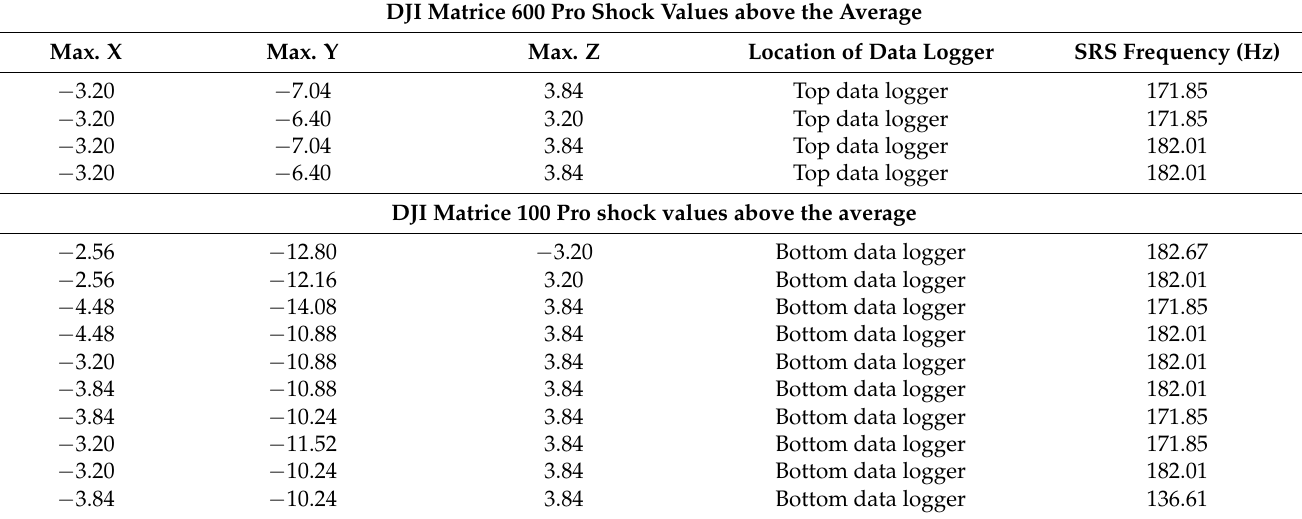
Table 6. Major shocks and their SRS frequencies.